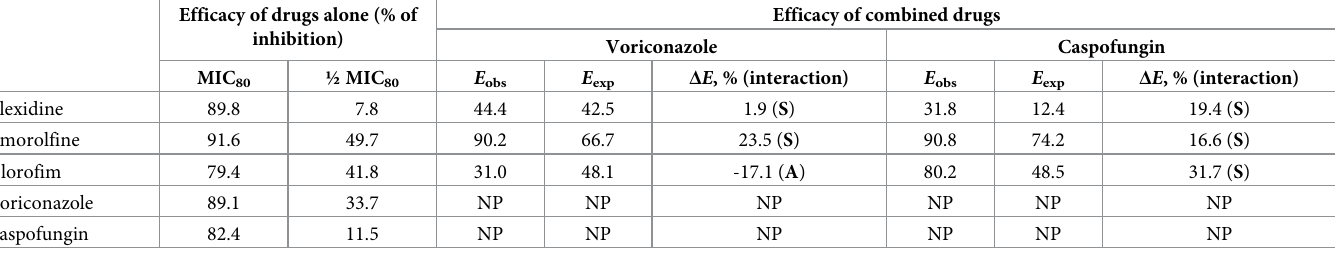
Table 4. Antifungal activity of alexidine, amorolfine, olorofim, voriconazole and caspofungin—alone and in combinations according to the Bliss independence model. Efficacy of drugs alone (% of inhibition)